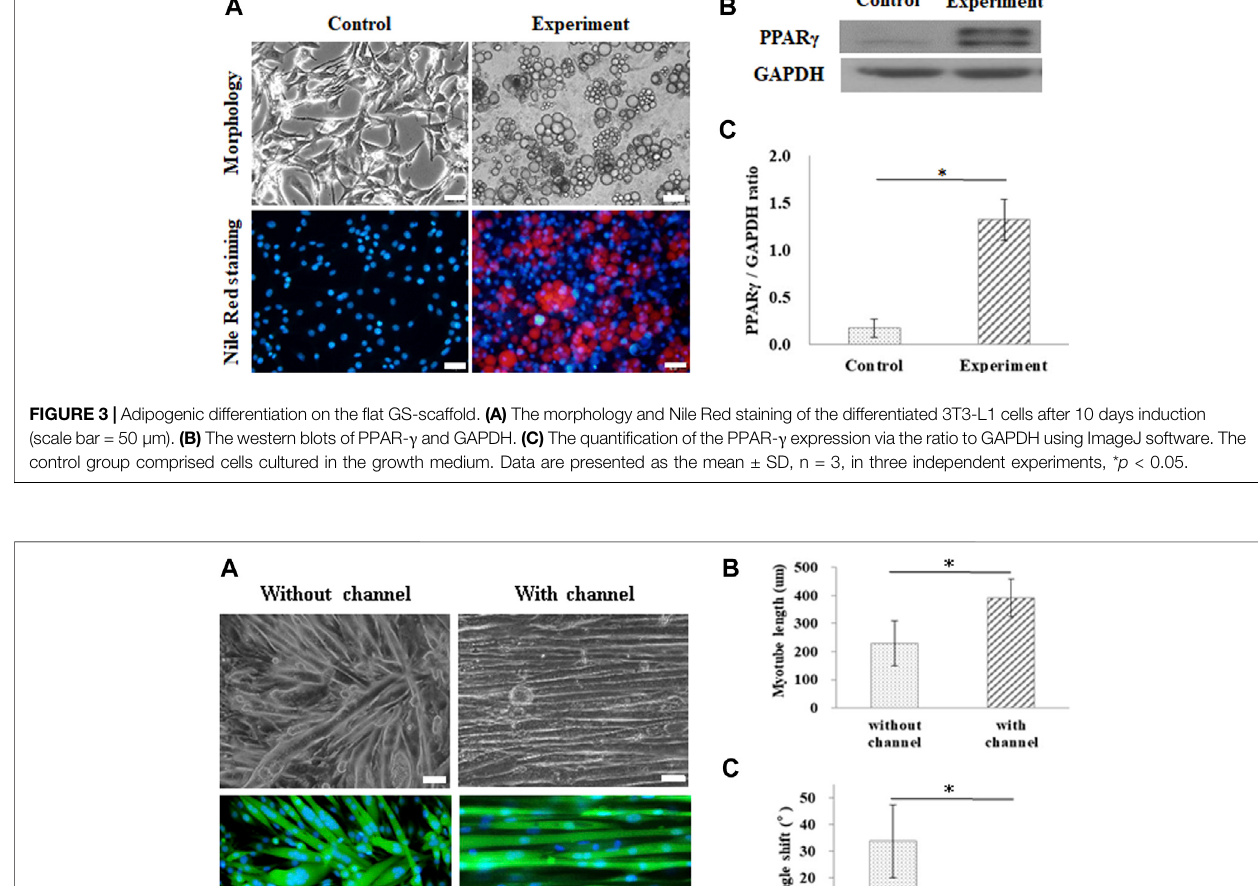
Frontiers in Bioengineering and Biotechnology |